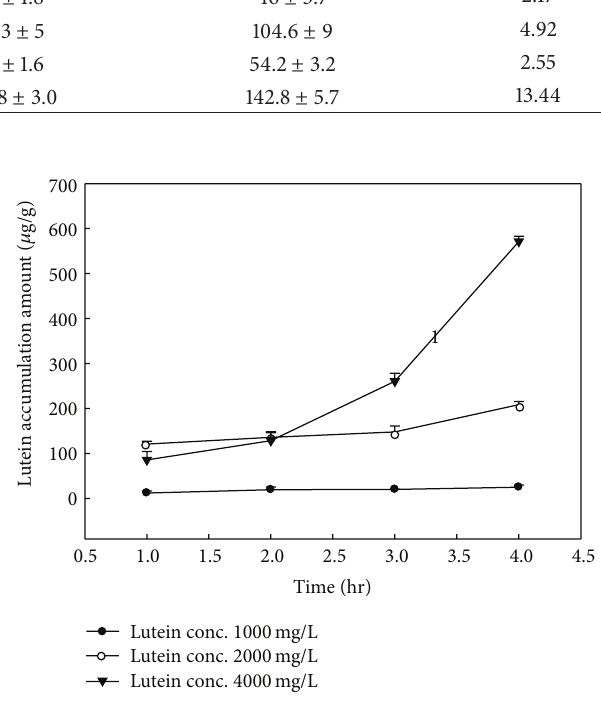
Figure 1: Dose effect of lutein on corneal accumulation using 2% HP 𝛽 CD combined